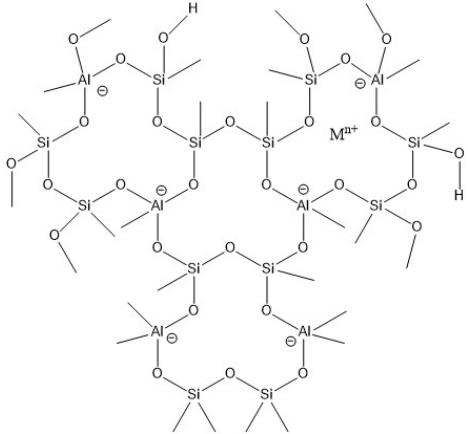
Figure 6. Zeolite skeletal